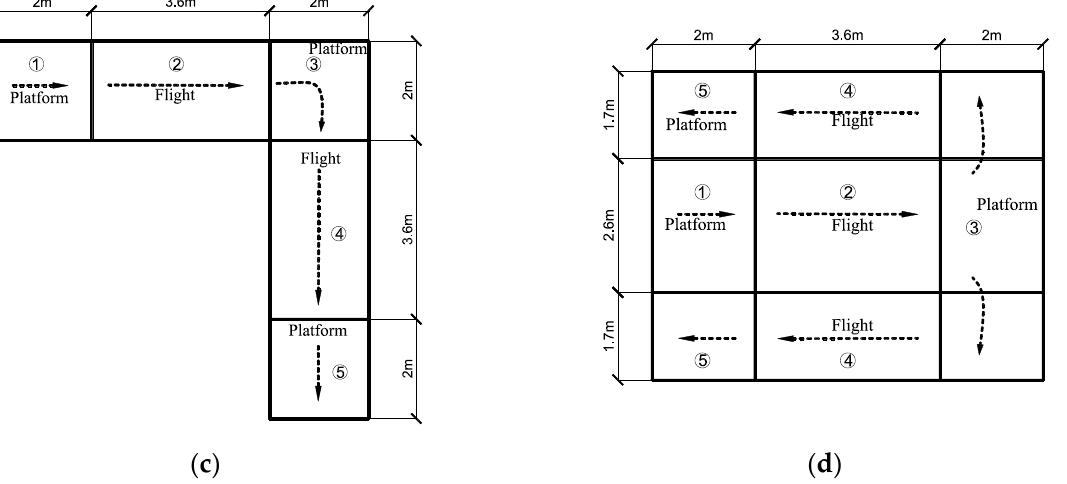
Figure 2. Basic information of the staircases. ( a ) Straight running stairs with platform (SSP), six floors; ( b ) double running parallel stairs (DPS), six floors; ( c ) corner stairs (CS), six floors; ( d ) double split parallel stairs (DSS), five floors.